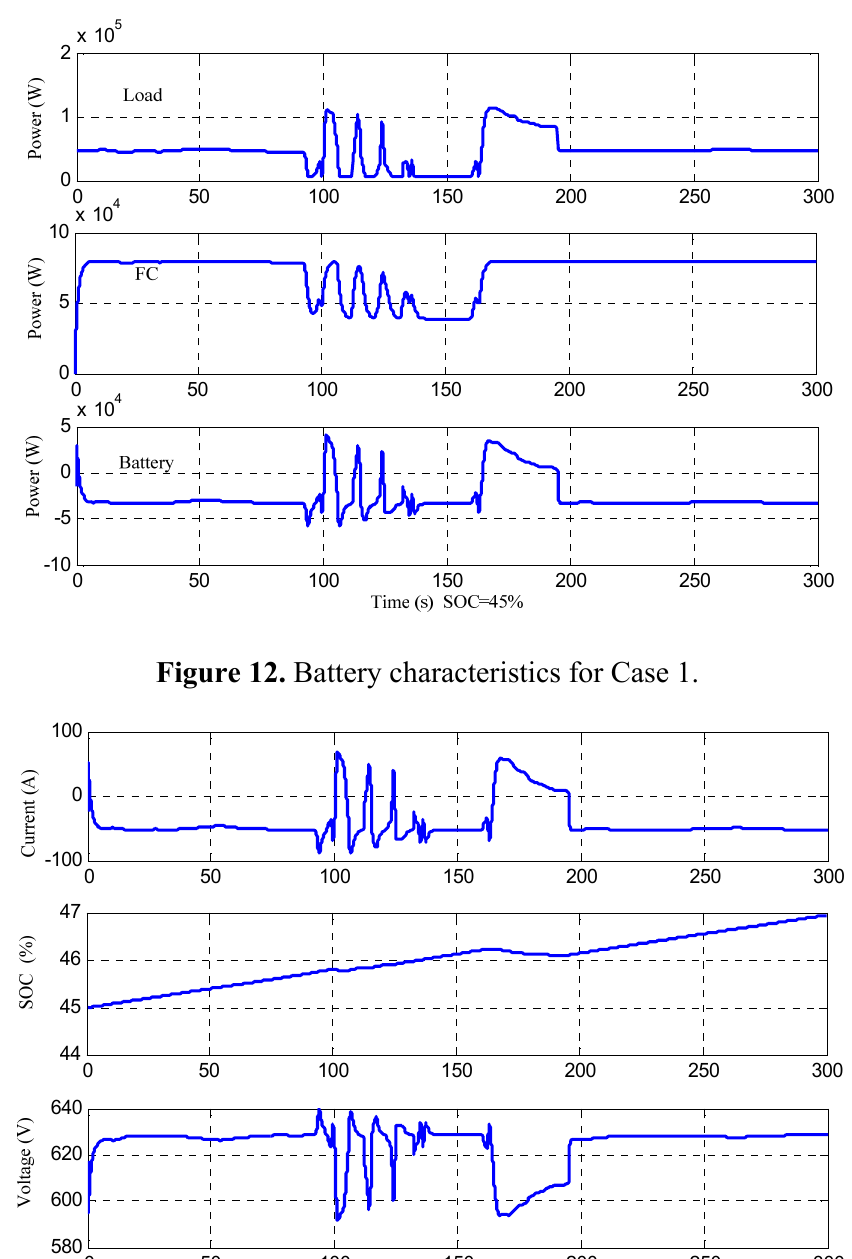
Figure 11. Power of load, FC and battery for Case 1.